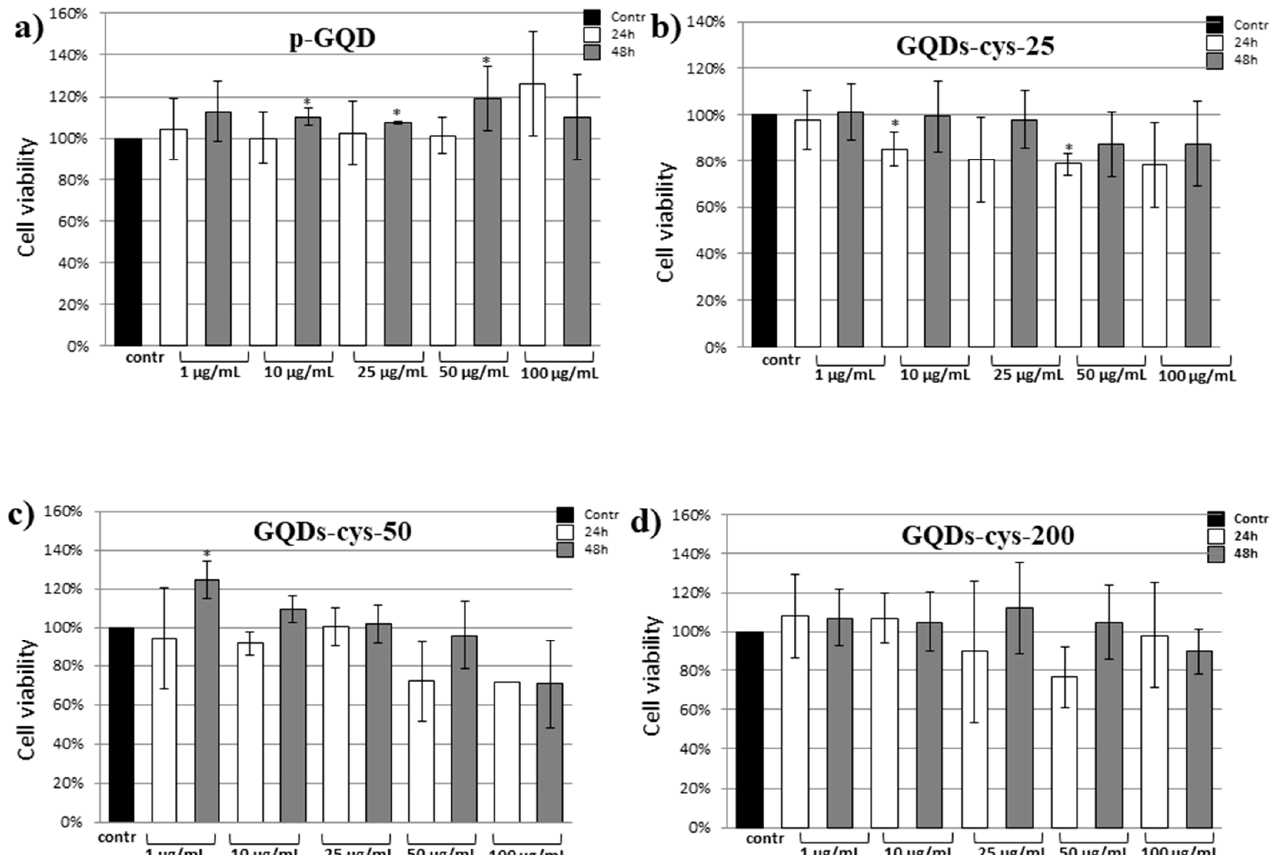
Figure 9. Cytotoxic activity of GQDs against HeLa cells: p-GQDs ( a ), GQDs-cys-25 ( b ), GQDs-cys-50 ( c ), and GQDs-cys-200 ( d ). Cells were treated for 24 and 48 h with increasing concentrations (1, 10, 25, 50, and 100 µg mL − 1 ) of the tested GQDs samples. Cell viability was expressed as the percentage of absorbance relative to the vehicle control (HeLa cells treated with methanol), which was set at 100%. Data are presented as the mean ± SD of at least three independent experiments. Asterisk denotes a significant difference from the control (* p < 0.05). SD—standard deviation.